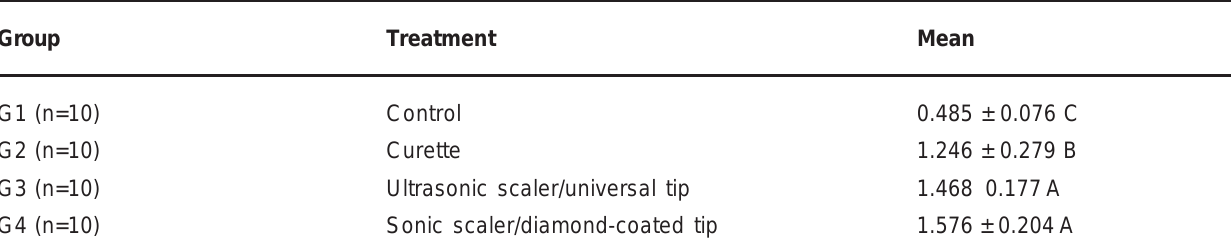
Mean values followed by different letters exhibited statistical difference (p<0.05)